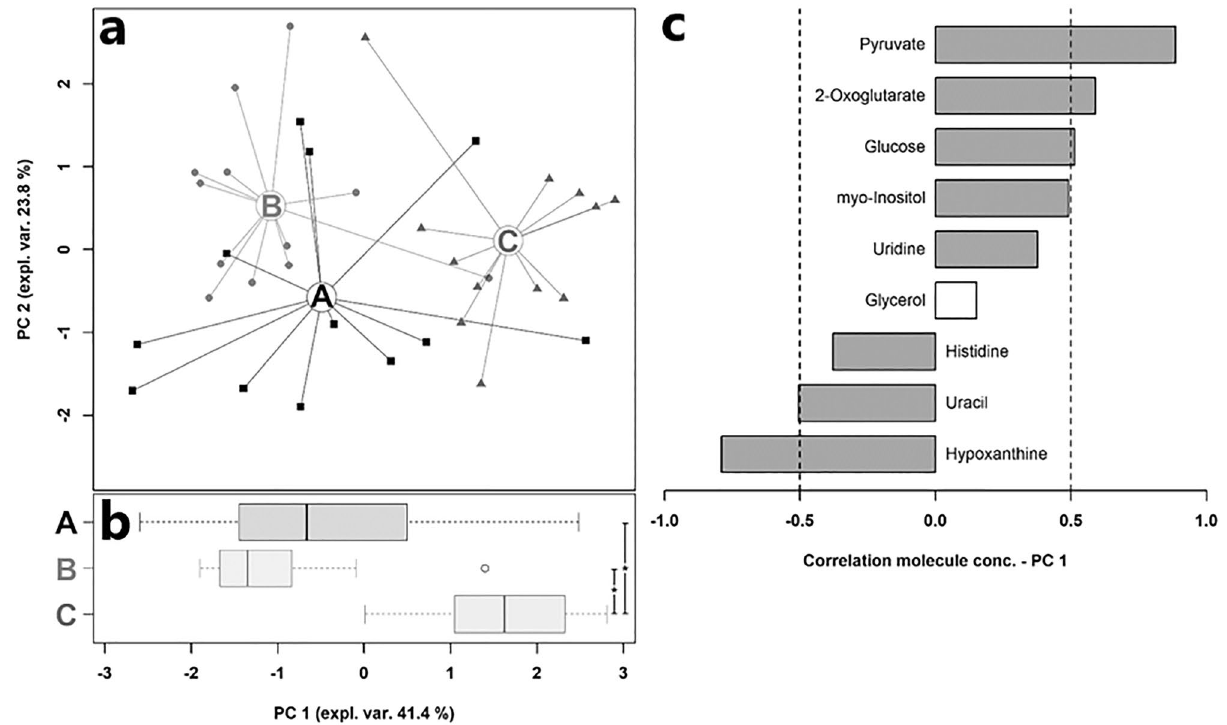
Figure 12. rPCA model on plasma metabolites of Table 5. In the score plot ( a ), samples of CON (“A”), MUL (“B”), and MUH (“C”) are drawn as squares, circles, and triangles, respectively. Wide circles are the group medians. The box plot ( b ) summarizes the position of samples along PC1. The loading plot ( c ) reports the correlations between the concentration of each metabolite and its importance over PC1. Grey bars indicate significant correlations ( p -value <